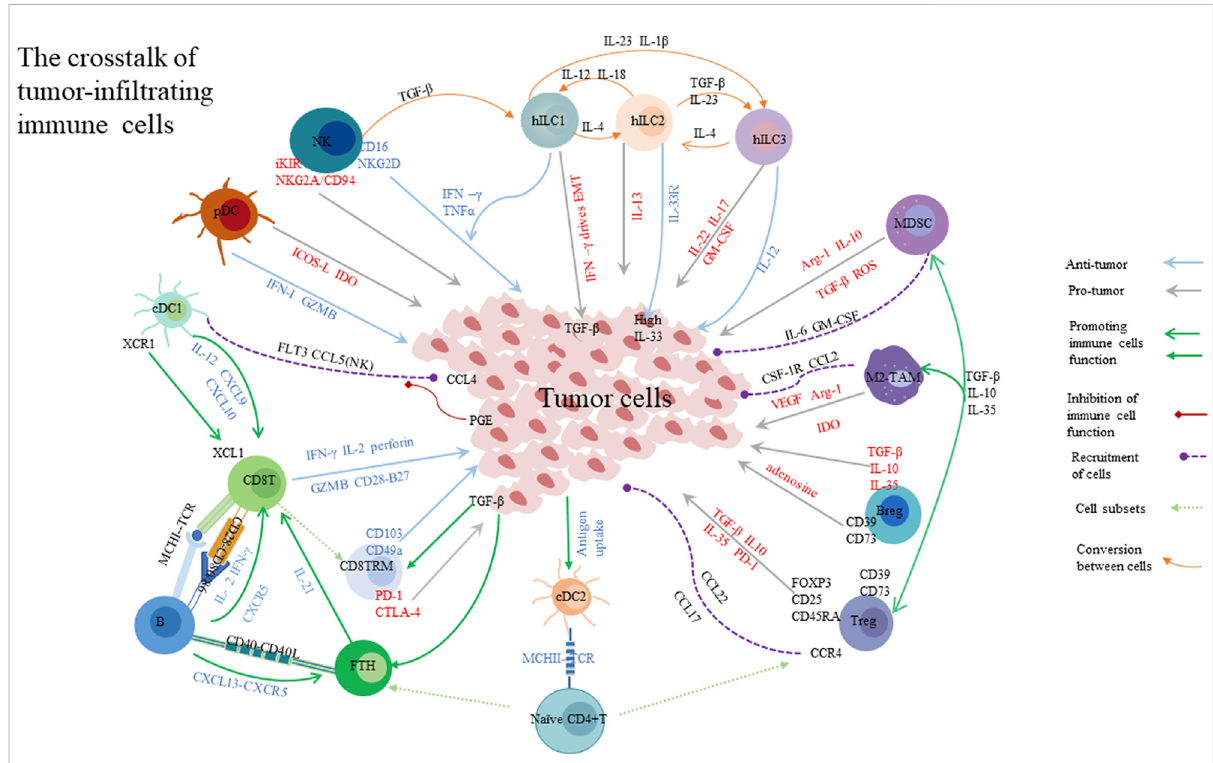
FIGURE 2 Tumor-in fi ltrating immune cells are important. Different cells play different roles. CD8+ T cell, CD8 TRM, and NK could kill tumor cells. Bregs, Tregs, MDSCs, and M2-TAM promote tumor cell growth. Tumor cells also secrete various molecules to disturb immune cell function. These moleculescanconvertcellphenotypeandchangetheirfunction,likeNKcells.Specially,TGF- β derivedfromtumorcellscouldpromotethefunction of CD8 TRM and Tfh cells. The crosstalk of these immune cells are is important for their function. Inhibitory cells secrete various immunosuppressive molecules to impair the cytotoxicity of effector cells. CD8 TRM: CD8 tissue resident memory; DC: dendritic cell; cDCs: conventional dendritic cells; pDCs: plasmacytoid DCs; Tfh: T follicular cell; NK: natural killer; hILC: helper innate lymphoid cells; Bregs: regulatory B cells; Tregs: regulatory T cells; MDSC: myeloid-derived suppressor cell; M2-TAM: M2 macrophages; EMT: epithelial mesenchymal